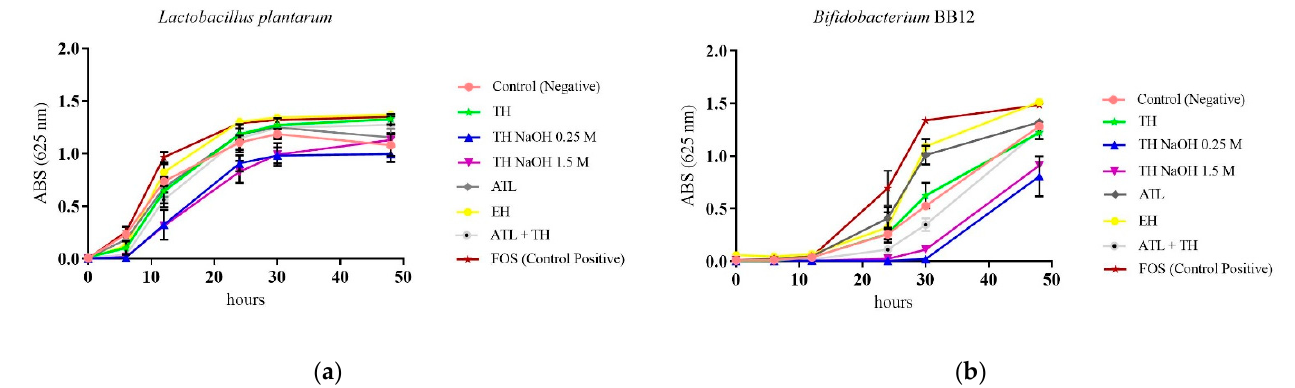
Figure 6. Growth curves of Lactobacillus plantarum ( a ) and Bifidobacterium animalis BB12 ( b ) in MRS broth supplemented with FOS, glucose or with mannans TH, TH NaOH 0.25 M, TH NaOH 1.5 M, ATL, ATL + TH and EH extracts, over 48 h incubation at 37 ° C.